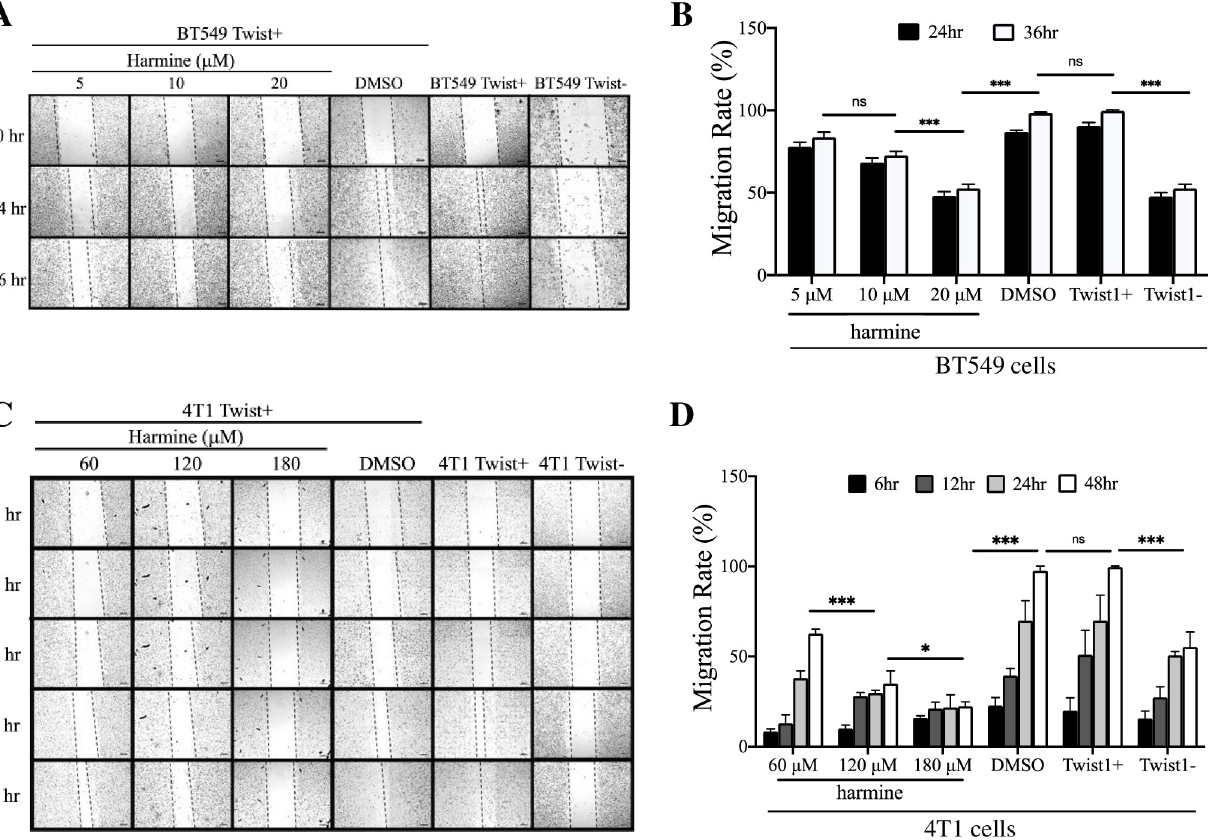
Fig 1. Harmine inhibits migration of breast cancer cells in wound healing assays. A, BT549 cells were treated with harmine (5, 10, 20 μ M) or DMSO (solvent control) and images were captured at different time points (0, 24, and 36 hr). Untreated BT549 Twist+ and BT549 Twist- cells were included as positive and negative controls for migration, respectively. Images are from a single experiment. The scale bars represent 200 μ m. B, Quantitative analysis of results from three independent experiments including the one shown in A. Statistical significance was determined based on data from 36 hr. C, 4T1 cells were treated with harmine (60, 120, 180 μ M) or DMSO (solvent control) and images were captured at different time points (0, 6, 12, 24, and 48 hr). Untreated 4T1 Twist+ and 4T1 Twist- cells were included as positive and negative controls for migration, respectively. The black particles in images under 120 μ M and 180 μ M are harmine. Images are from a single experiment. The scale bars represent 200 μ m. D, quantitative analysis of results from three independent experiments including the one shown in C. Statistical significance was determined based on the data from 48 hr. Definitions of statistical significance are � p < .05, �� p < .01, ��� p < .001, and ���� p <